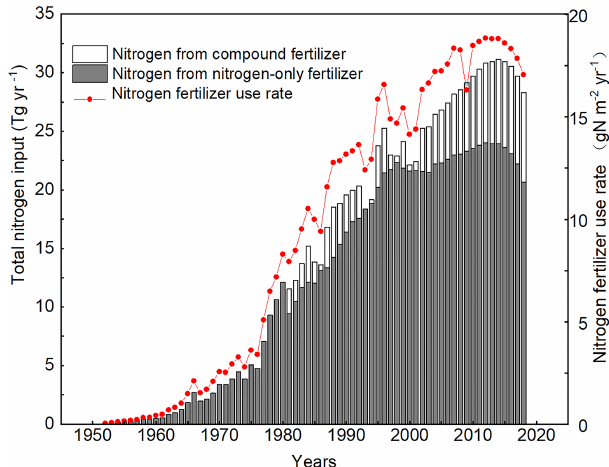
Figure 2. Total nitrogen fertilizer input and the average nitrogen fertilizer use rate in China’s cropland from 1952 to